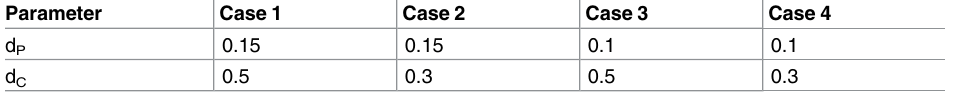
Table 1. Values for predator and consumer mortality rates altered to change the relative interaction strengths to represent the four possible dynamic starting